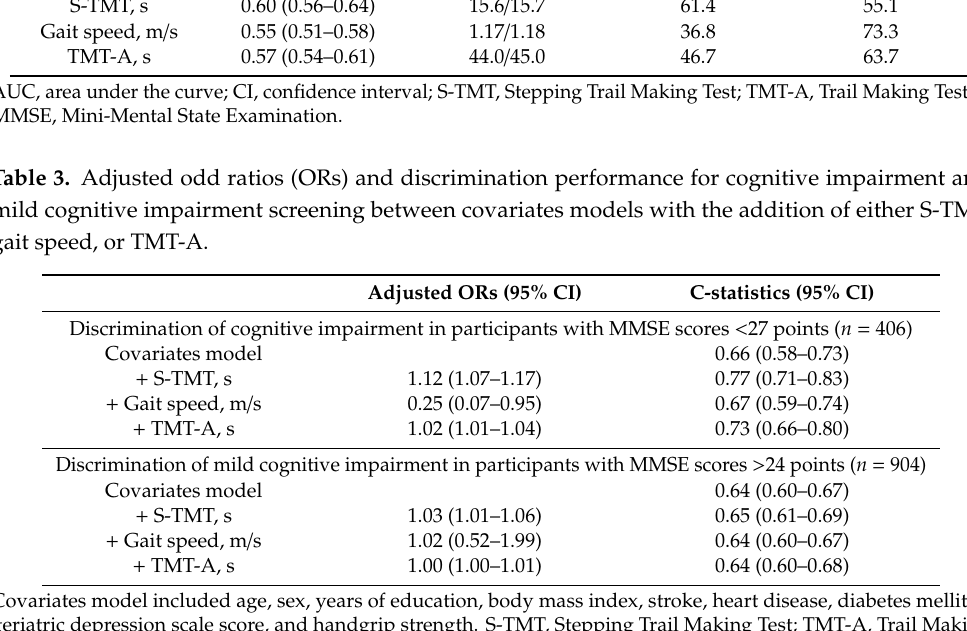
Table 4. Comparisons of reclassification indices for screening cognitive impairment and mild cognitive impairment between the addition of S-TMT or either gait speed or TMT-A to the covariates model. cNRI (95% CI) p IDI (95% CI) p Reclassification of the cognitive impairment in the participants with MMSE scores < 27 points ( n = 406) Covariates + Gait speed model